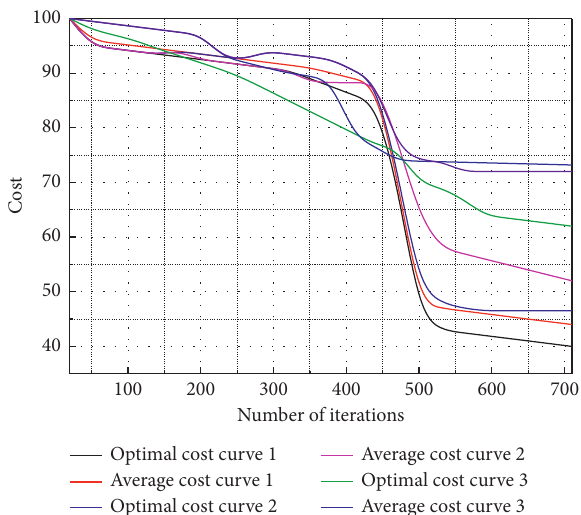
Figure 8: Distribution process of distribution center routing.